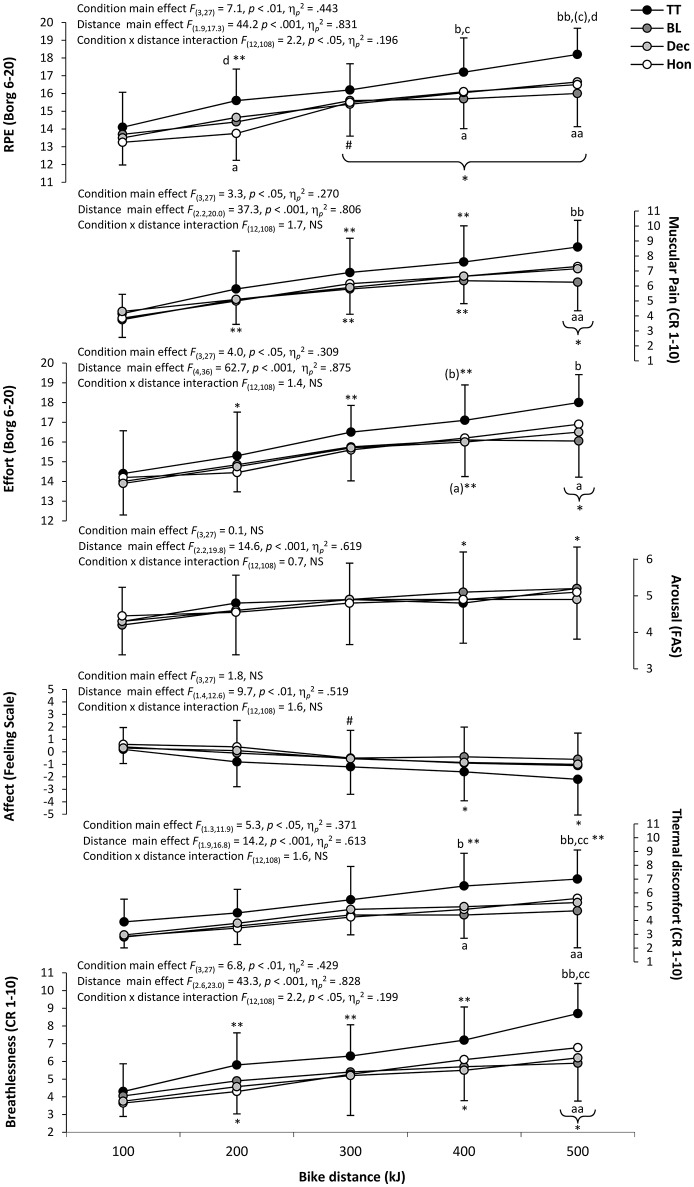
Mean ± SD perceptual responses for each 100 kJ cycle section. Significantly different from; TT, (a)p = 0.051, ap < 0.05, aap < 0.01; BL, (b)p = 0.051, bp < 0.05, bbp < 0.01; DEC,(c)p = 0.051, cp < 0.05, ccp < 0.01; HON, dp < 0.05, ddp < 0.01; initial value, *p < 0.05, **p < 0.01; previous value, #p < 0.05 (parentheses indicate significance in all conditions).